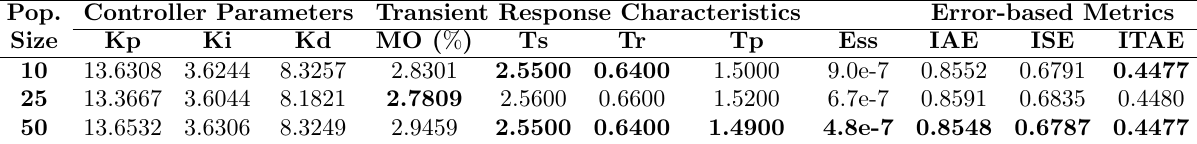
Table 6. Effect of population size on system dynamic response, steady-state error and perfor- mance